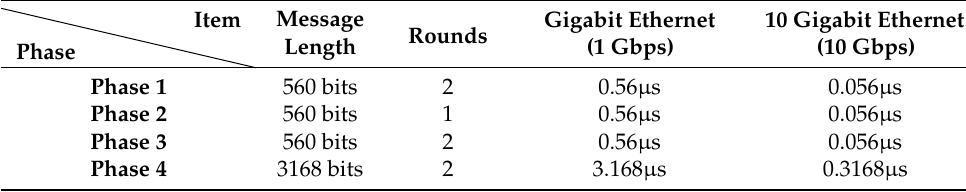
Table 4. Analysis of the communication